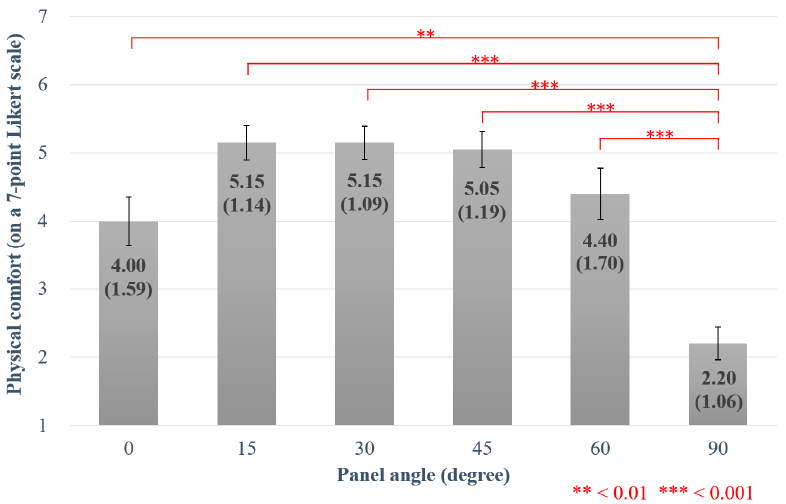
Figure 4. Physical comfort ratings with the results of post hoc multiple comparisons.